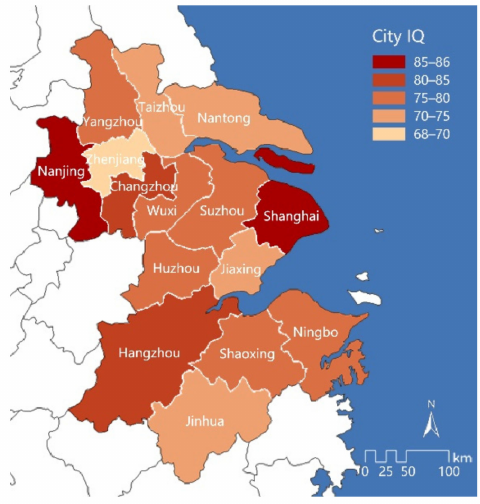
Figure 4. CityIQ scores of the fifteen major cities in the Yangtze River Delta region, China. Based on the historical scores and indicators of the cities evaluated in the database, and the comparisons according to various dimensions, disadvantages in the construc- tion of intelligent cities can be derived. The ranking presents overall information about the intelligent development of these fifteen cities in the Yangtze River Delta based on the five-dimensional indicators (shown in different colors in the histogram in Figure 5). Shanghai tops the list with 86.0 points. In general, the provincial capital cities have higher CityIQ scores than non-provincial ones, but the strengths and weaknesses of each city are noticeably